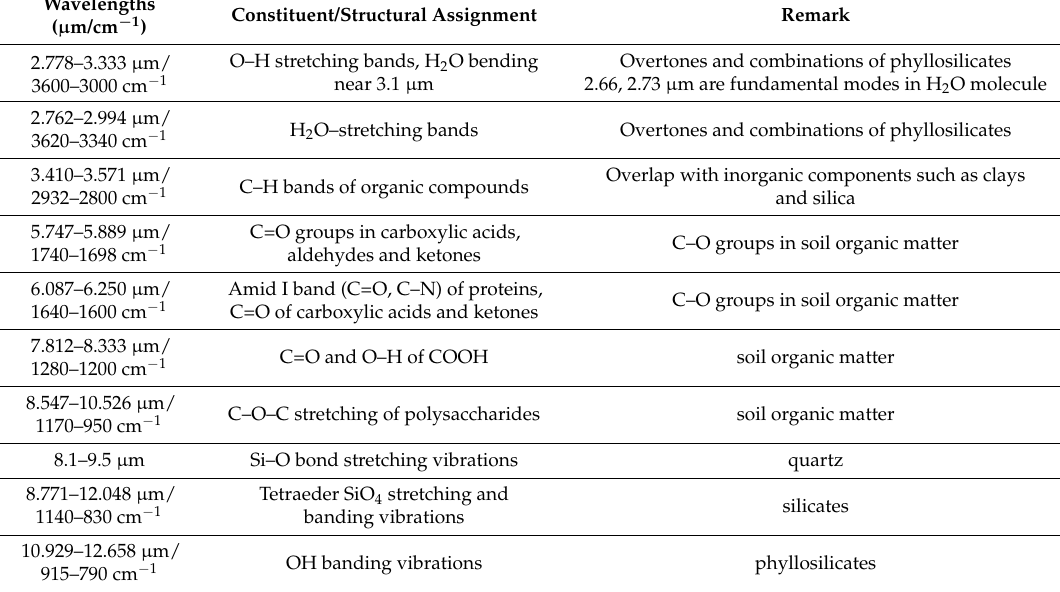
Table 10. Band assignments of identified MWIR–LWIR wavenumbers (these were compiled from [46,53–58]. As the results published by the scientific community commonly use the wavelength ( µ m) and/or wavenumber (cm − 1 ) scales, both scales are used to make the results comparable and